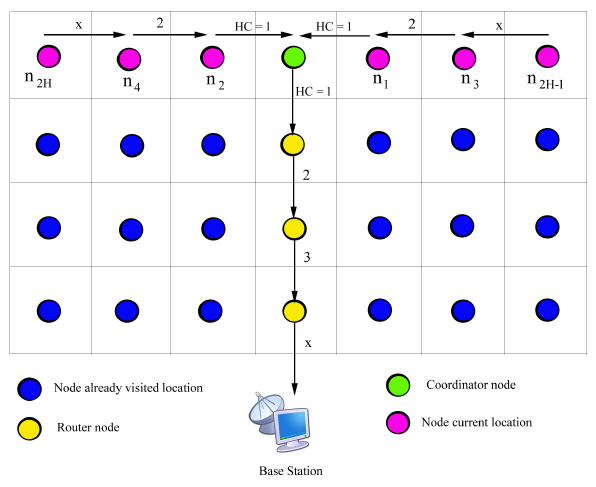
Figure 3. T-based routing